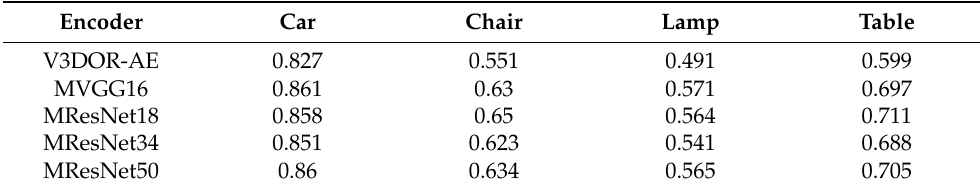
Table 1. IOU values of VoxGen using different encoders. Encoder Car Chair